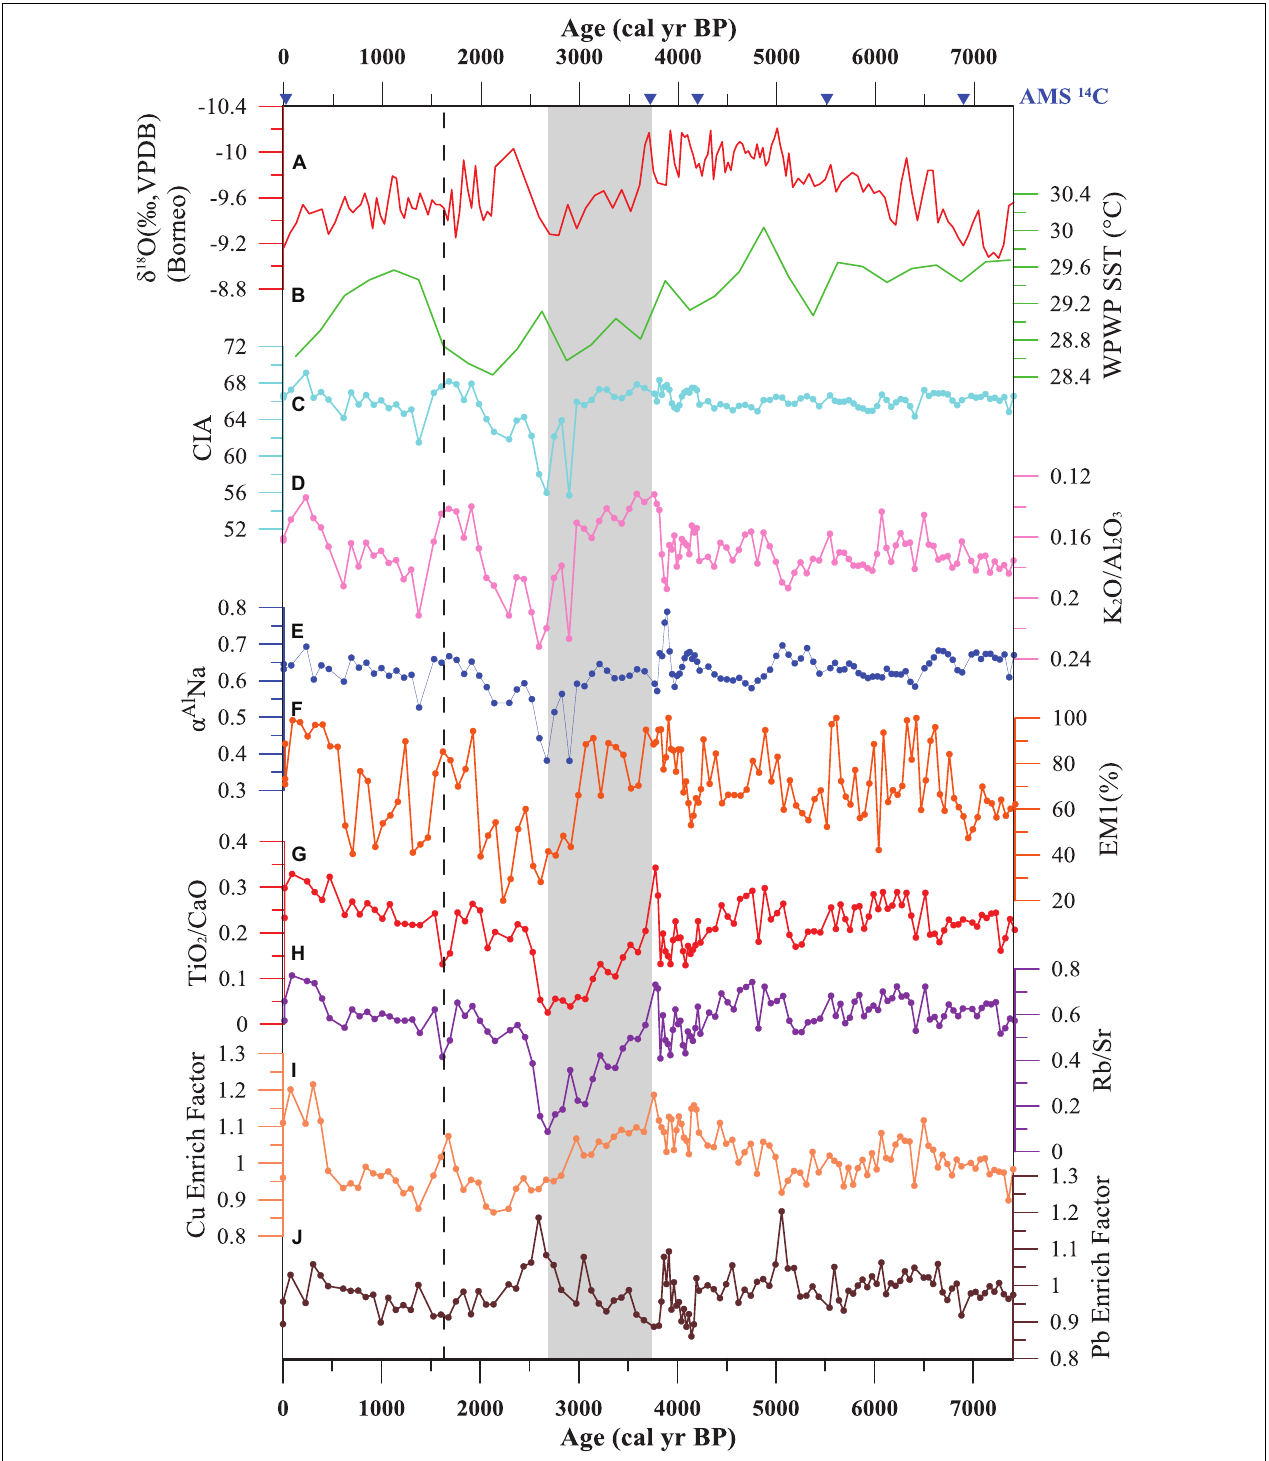
FIGURE 8 | Comparison of the Core K17 records with other representative paleoclimate records since 7400 cal yr BP: (A) Rainfall patterns from Borneo cave stalagmite δ 18 O (Partin et al., 2007); (B) sea surface temperature (SST) of the Western Pacific Warm Pool (WPWP; Stott et al., 2004); (C) CIA from Core K17; (D) K 2 O 3 /Al 2 O 3 from Core K17; (E) α AlNa from Core K17; (F) EM1 volume from Core K17; (G) TiO 2 /CaO from Core K17; (H) Rb/Sr from Core K17; (I) Cu enrichment factor from Core K17; and (J) Pb enrichment factor from Core K17. The shadow area represents the interval of the second stage. The dotted line represents the boundary of third stage and fourth